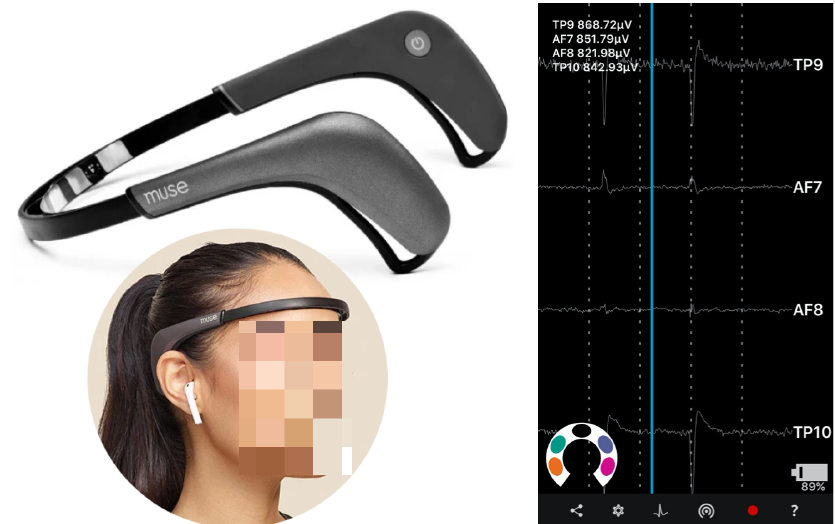
Figure 1. Traditional usage of Muse in